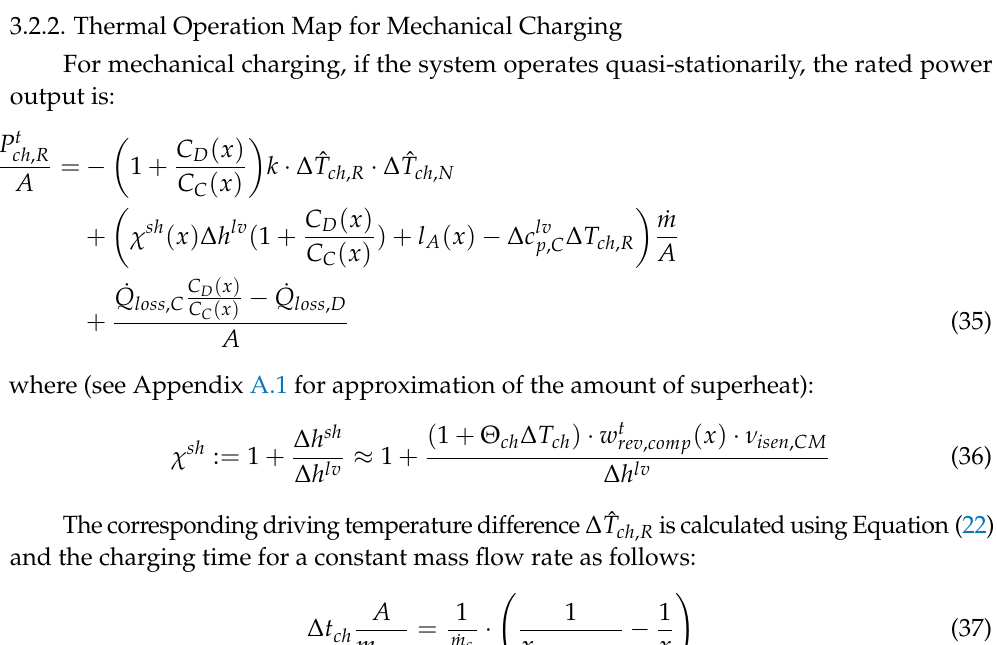
Figure 13. Operation map of the discharging process with the same parameters as in Table 3 but with k = 1000 W/(K m 2 ). Transparent in the background for comparison, the map is shown at the reduced storage temperature of T S = 80 ◦